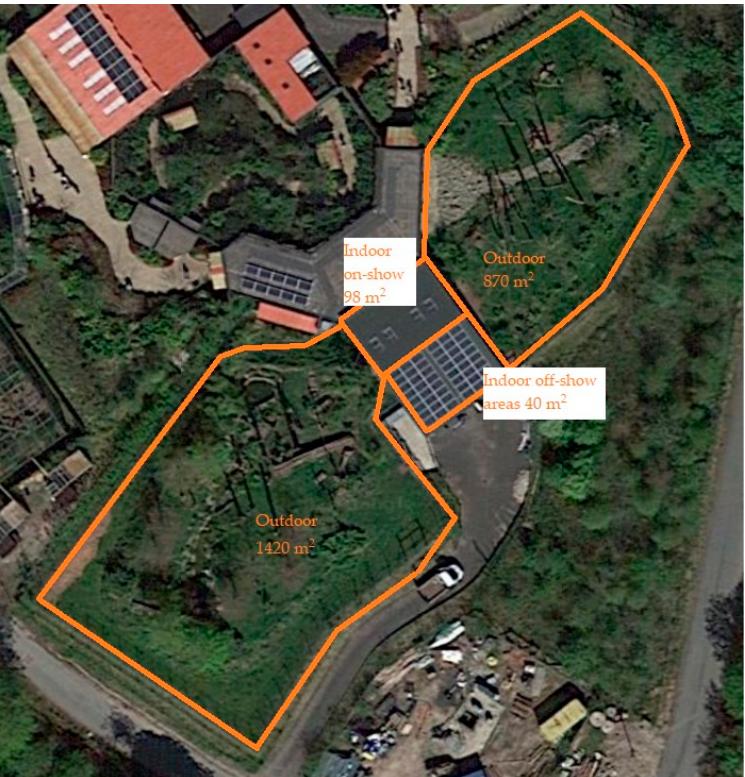
Figure A6. Enclosure plan for Malayan sun bear ( Helarctos malayanus ) in the new Islands expansion. Orange lines signify approximate areas accessed by individual animals with dimensions of total available space. Copyright: Google Earth.